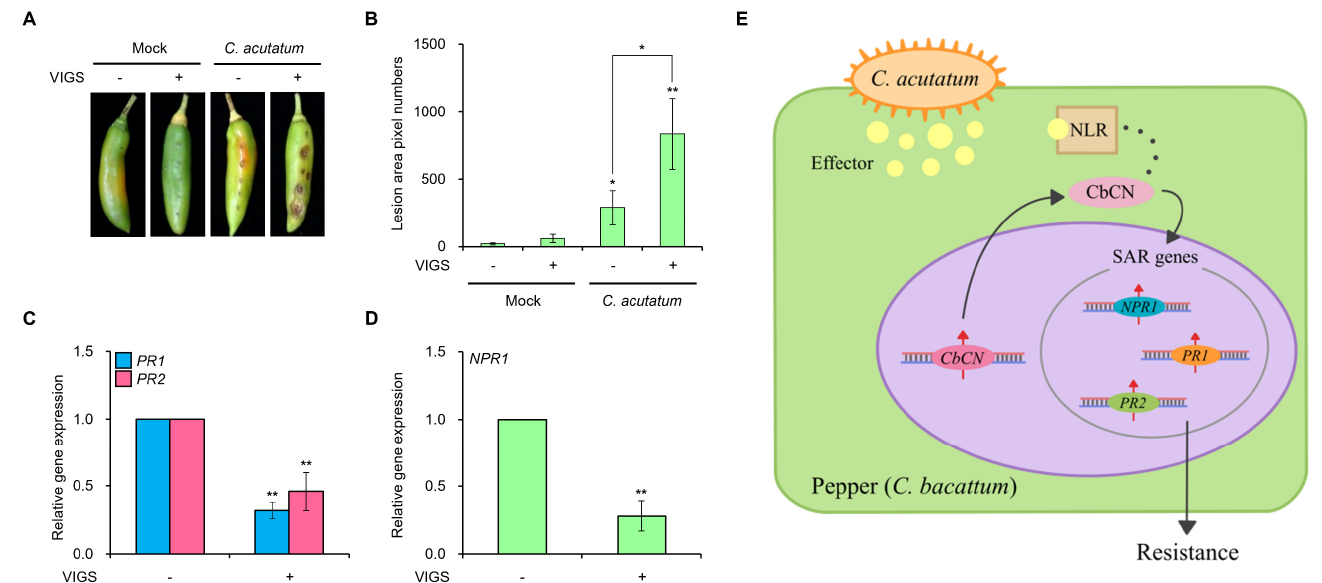
Figure 4. Anthracnose susceptibility and gene expression analysis in CbCN -silenced chili pepper fruits after C. acutatum inoculation. ( A , B ) Pathogen susceptibility assays of VIGS-mediated CbCN -silenced chili pepper fruits after C. acutatum inoculation. Chili pepper fruits of CbCN -silenced and wild-type plants were inoculated with C. acutatum or mock treatments. Images were captured after 6 days ( A ) and quantitative measurements of the disease area were obtained using the image-based plant disease phenotyping method ( B ). Values are expressed as means ± SDs. Asterisks indicate values statistically different from mock without VIGS and between present or absent of VIGS within C. acutatum inoculation (* p < 0.05 and ** p < 0.01). ( C , D ) Expression analysis of defense-response genes. Transcriptional levels of the SAR marker genes PR1 and PR2 ( C ) and SAR master regulator NPR1 ( D ) were measured in CbCN -silenced chili pepper fruits after 6 days of C. acutatum inoculation using RT-qPCR. Actin served as a control. Values are expressed as means ± SDs. Asterisks indicate values statistically different from those of controls (** p < 0.01). ( E ) A working model of CbCN involvement in innate immunity against C. acutatum . The solid arrows indicate the role of CbCN verified in this study. The dashed line indicates hypothetical a process. All experiments were repeated at least three times and they generated similar